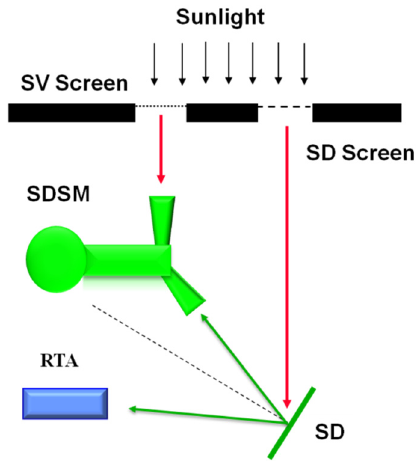
Figure 3. Schematic diagram for SD/SDSM calibration.